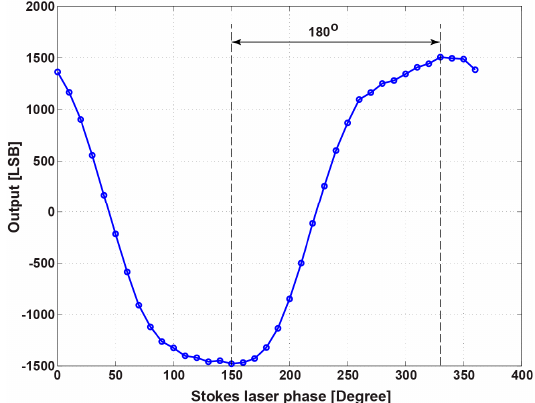
Figure 17. Pixel output as a function of the laser modulation.